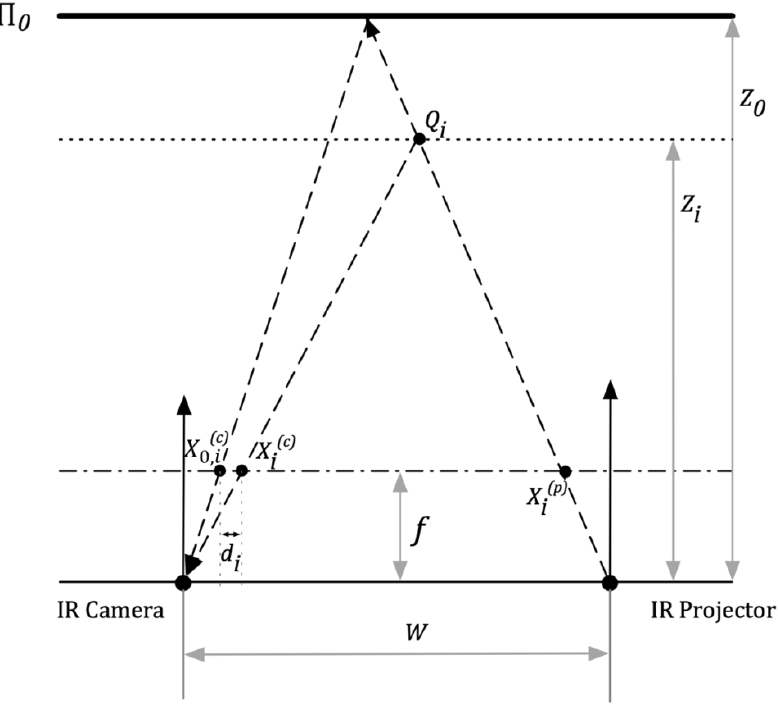
Figure 1. Work principle of structured light (SL)-based depth sensor.